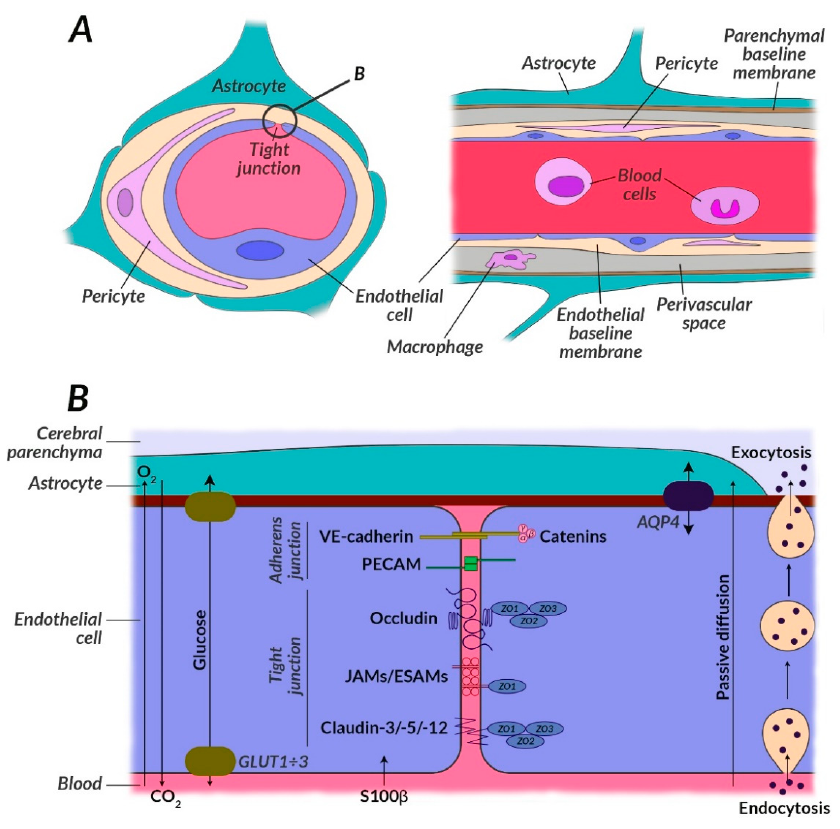
Figure 2. Structure of the neurovascular unit (NVU) with particular attention to the glucose metabolism impairment. ( A ) NVU contains the blood-brain barrier (BBB) which consists of many di ff erent cells including astrocytes, pericytes, neurons, microglia, and endothelial cells. The brain cells can work with each other when metabolic demand on glucose and other substrates is enough. BBB provides crossing of important substrates for mitochondrial metabolism, e.g., glucose, removal of toxic superoxides, e.g., carbon dioxide, and reduce access to the brain of potentially damaging molecules in the bloodstream, e.g., some drugs. BBB constitutes a protection against harmful factors due to the mechanisms of active intercellular transport or control by proteins transporting energy substrates located in the vascular endothelial cell membrane (e.g., GLUT1). ( B ) Intracellular transport is regulated by protein complexes located between endothelial cells, i.e., ESAM, AQP4, GLUT1, PECAM, JAMs, VE-cadherin, peripheral proteins of tight junctions (ZO1 ÷ 3), claudine (3, 5, 12), and occludin. GLUT3 is seen in neurons, and GLUT1 in endothelial cells; GLUT2 is a glucose sensor present in the hypothalamus in the brain. In the course of schizophrenia, the GLUT1 translocation process, and thus glucose transport, is impaired, among others due to the e ff ect of harmful oxidative stress, inappropriate mitochondrial metabolism, and impaired mTOR pathway. BBB also regulates the exchange of other components, e.g., calcium, elements of the immune system, or indicators of neurobiochemical focal lesions, i.e., S100 β protein. Tight connections in the brains of schizophrenic patients can be broken due to the presence of claudin-5-deficient areas. Their expression is reduced in the prefrontal cortex and they are absent along the blood vessels, which may be associated with the penetration of S100 β through BBB and, consequently, with a disorder of brain homeostasis. Abbreviations: AQP4: Aquaporin 4; BBB: Blood-brain barrier; ESAM: Endothelial cell-selective adhesion molecule; GLUT1: Insulin-independent glucose transporter; JAM: Junctional adhesion molecule; NVU: Neurovascular unit; PECAM: Platelet-endothelial cell adhesion molecule; VE-cadherin: Vascular endothelial cadherin; ZO1 ÷ 3: Peripheral proteins of tight junctions (zonula